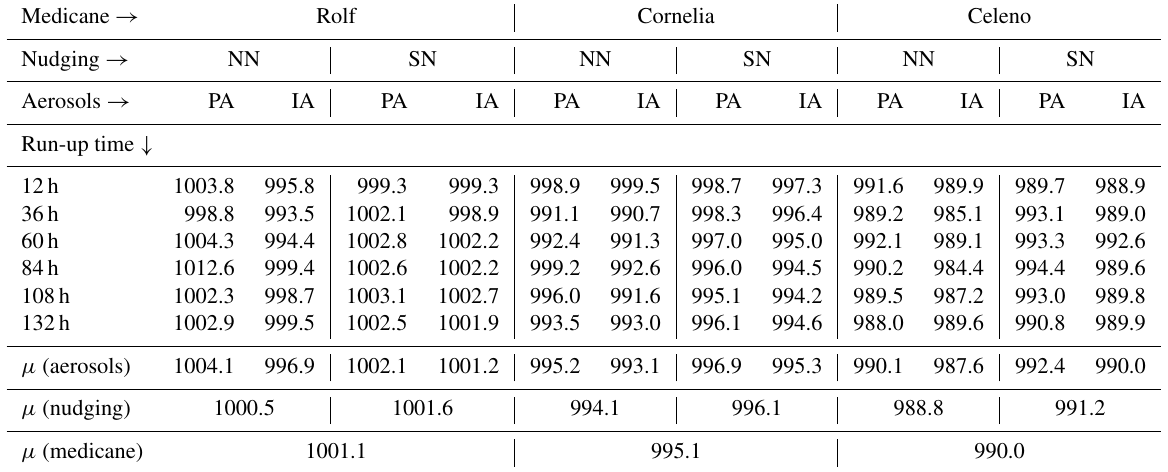
Table 1. Summary of the minimum SLP reached by the medicanes in the 72 simulation ensembles. The µ quantity reduces the ensemble through the sample mean for each aggregated recursive level.